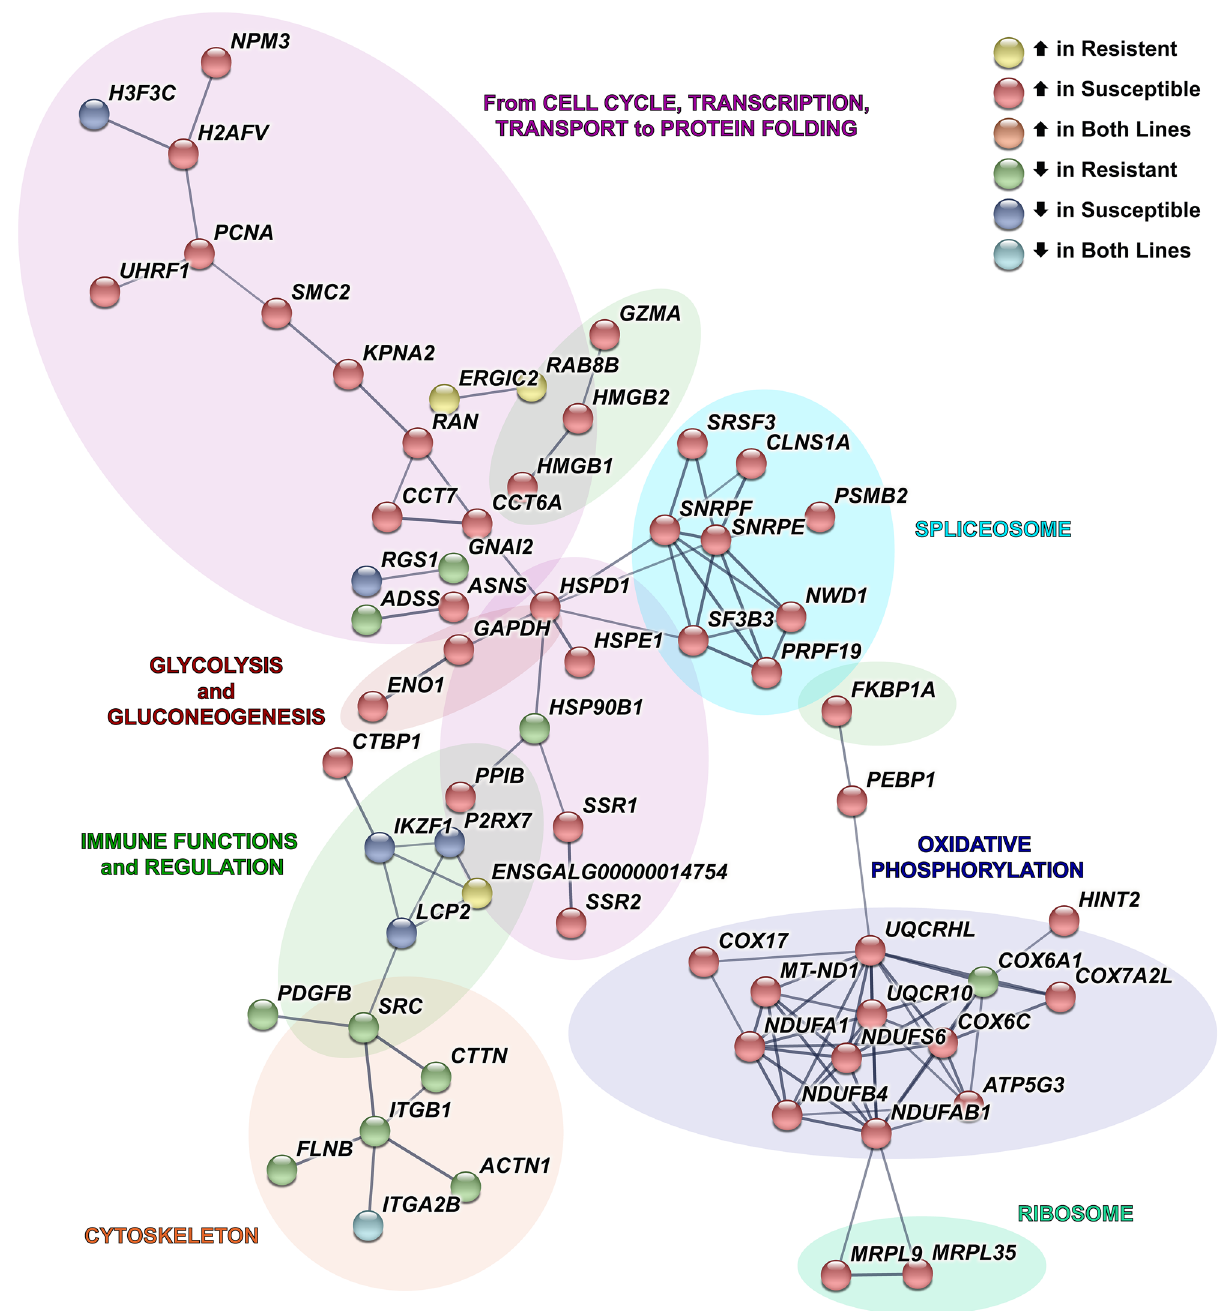
Figure 7. Network of DEGs in macrophages (1) after MDV infection. Within this cell type, connections between the significant differentially expressed genes (DEGs) from both lines cumulatively were identified using STRING (PPI enrichment p = 1.19e − 14). For each DEG, the direction of log 2 FC (MDV-infected compared to control) is shown by the fill color for its node. Edges (line thickness) represent the strength of connections (interaction scores) between DEGs. Background colors represent broad-level functions associated with the DEGs in each branch of the Antigen-presenting myeloid cells. These cells showed a moderate transcriptional response in both lines, with 31 and 18 DEGs in susceptible and resistant (Suppl. Tables 2 and 3). In resistant birds, two genes affiliated with the interferon activation pathway were increased upon infection, TNF alpha induced protein 2 ( TNFAIP2 ) and interferon induced protein with tetratricopeptide repeats 5 ( IFIT5 ). In contrast, JCHAIN is downregulated in both lines during viral infection (Suppl. Tables 2 and 3). Class II antigen presentation is decreased as seen with lower BLB2 and CD74 gene expression in only susceptible birds (Suppl. Table 2).